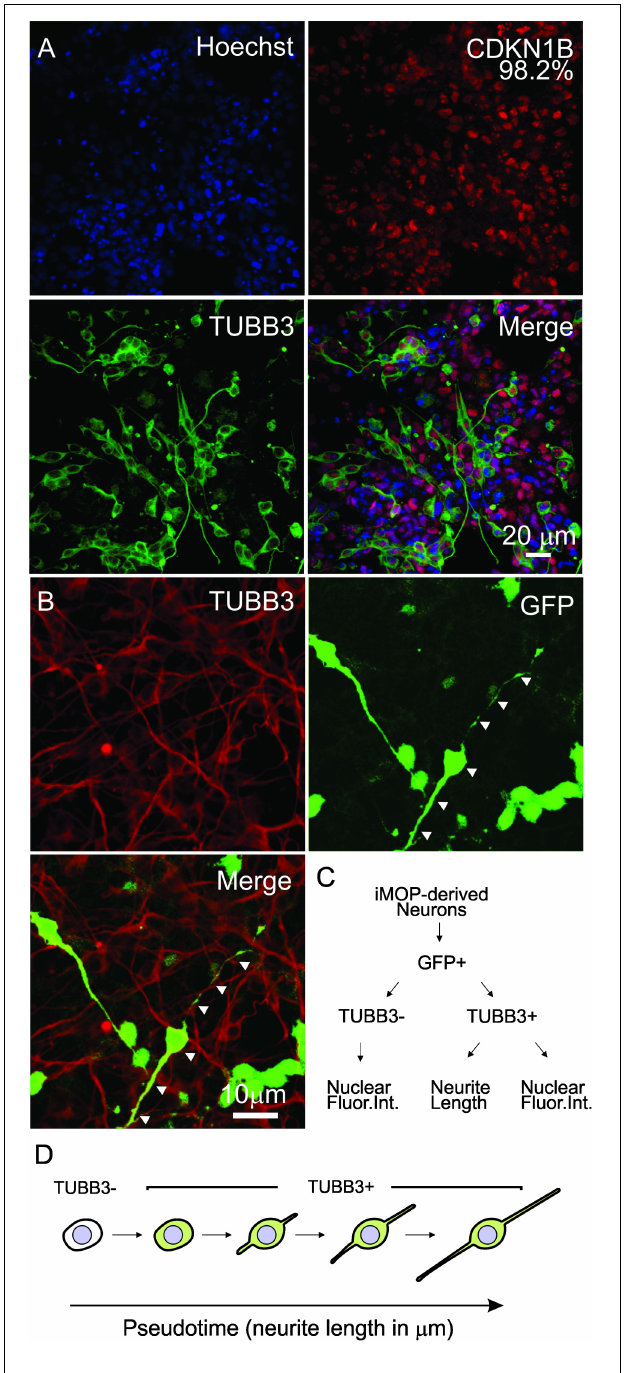
FIGURE 3 | Sparse labeling of iMOP-derived neurons for pseudotemporal ordering. (A) Nuclear labeling with Hoechst and immunostaining of iMOP-derived neuron with antibodies against CDKN1B and TUBB3. (B) Expression of GFP in TUBB3 marked cells by transfecting a GFP overexpression plasmid for sparse labeling and neurite tracing. Arrowheads mark the path of the neurite in a single neuron. (C) Workflow to identify GFP+ TUBB3– and GFP+ TUBB3+ cells for fluoresence intensity and neurite length measurements. (D) Arrangement of iMOP-derived neurons based on TUBB3 labeling and neurite lengths to generate a pseudotemporal ordering of cells that represent a differentiation trajectory. Scale bars as